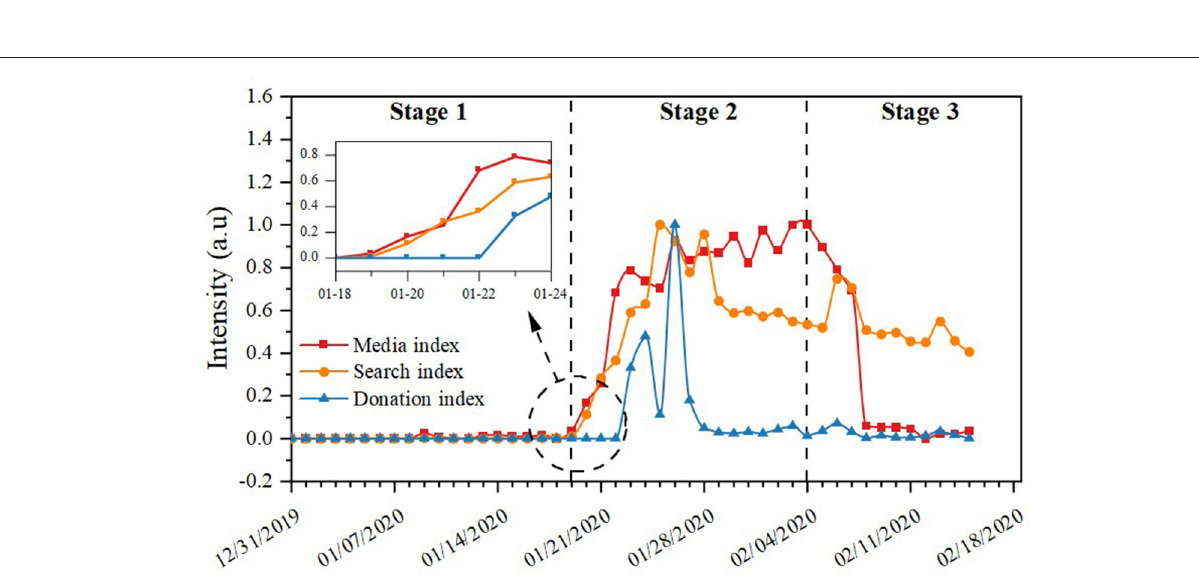
FIGURE 4 | Variations of media index, search index, and donation index in these three